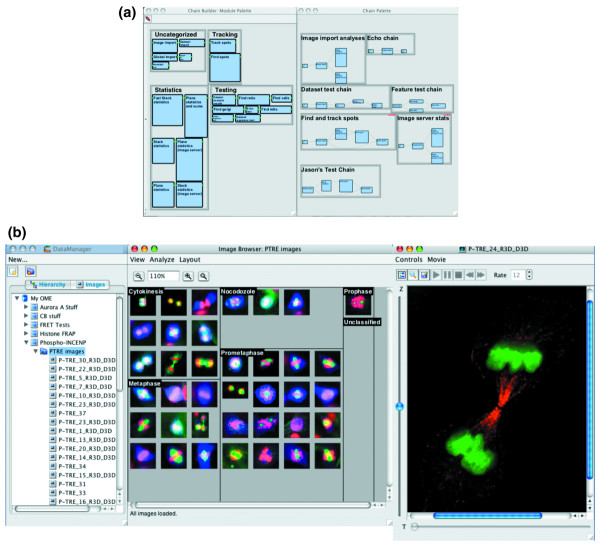
Using STs for visualization in OME. Examples of the use of STs for visualization of data within an OME database are shown. These tools are Java applications that access OME via the OME remote framework [34]. All OME code is available [31]. (a) The Chain Builder, a tool that enables a user to build analysis chains by ensuring that the input requirements of a given module are satisfied by outputs from previous modules. This is achieved by accessing the STs for the inputs and outputs within an OME database. (b) The DataManager, DatasetBrowser and 5DViewer. The DataManager shows the relationships between Projects, Datasets and Images within an OME database. The DatasetBrowser modifies the display method for images within a given dataset depending on the values of data stored as STs within an OME database. The 5Dviewer allows visualization of individual images based on STs in an OME database.